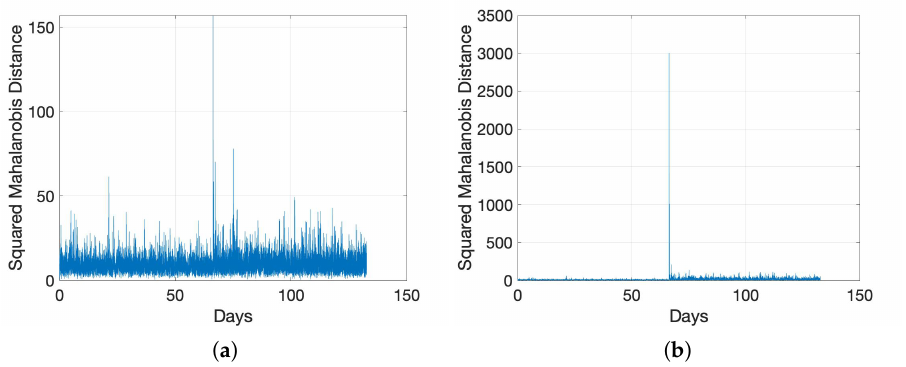
Figure 6. SMD for mild and medium DFs whose SNRs are presented in Figure 5. ( a ) Mild DF; ( b ) Medium DF.